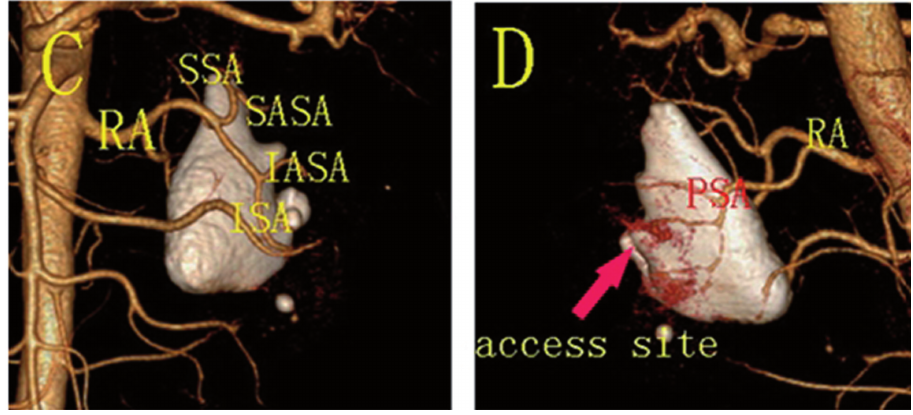
C) Frontal view; D) Posterior view. The access site is indicated by the red arrow. RA= renal artery; SSA=superior segmental artery; SASA= superior anterior segmental artery; IASA =inferior anterior segmental artery; ISA= inferior anterior segmental artery; PSA= posterior segmental